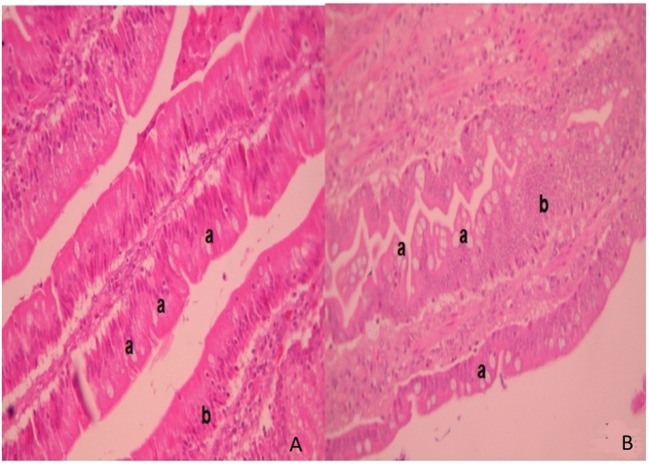
Intestinal villi. Intestinal histopathology microphotography in the control group (A) and F4 group (B) of laying hens. Into F4 group the villi with abundant goblet cells are highlighted (a) next to the mucus layer with an increased number of lymphocytes inside the villi (b) stained with hematoxylin/eosin. Magnification: 400×.